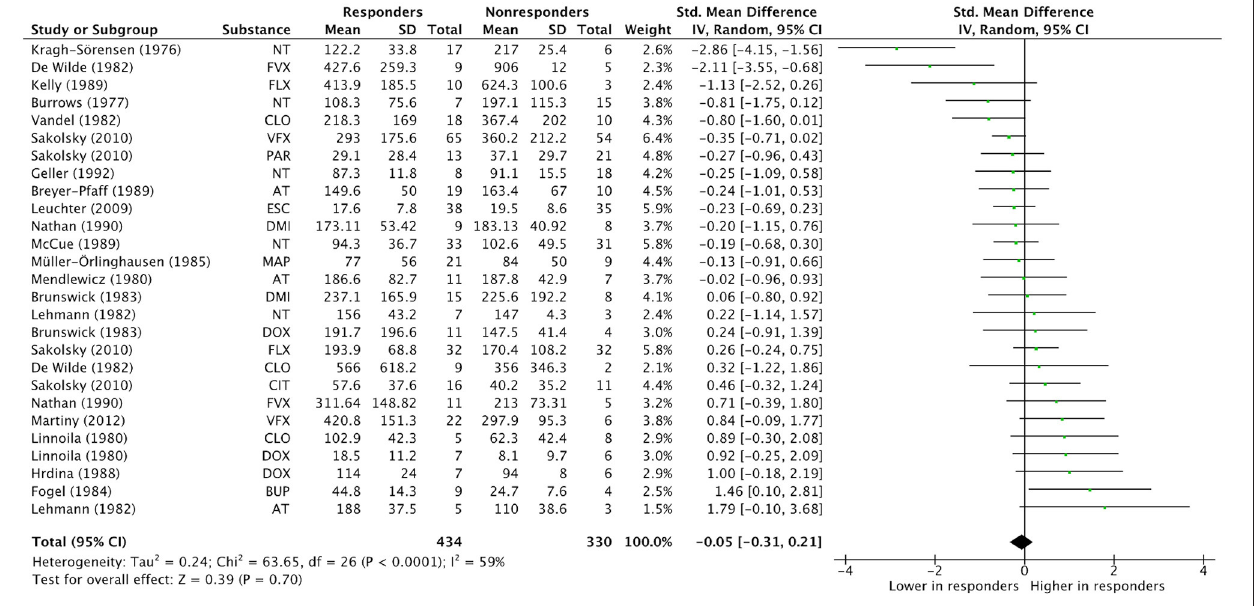
FIGURE 1 | Overall effect estimate. Overall effect estimates across N treatment arms = 27, in N = 19 studies. AT, Amitriptyline; BUP, Bupropion; CIT, Citalopram; CLO, Clomipramine; DMI, Desipramine; DOX, Doxepin; ESC, Escitalopram; FLX, Fluoxetine; FVX, Fluvoxamine; MAP, Maprotiline; NT, Nortriptyline; PAR, Paroxetine; VFX,